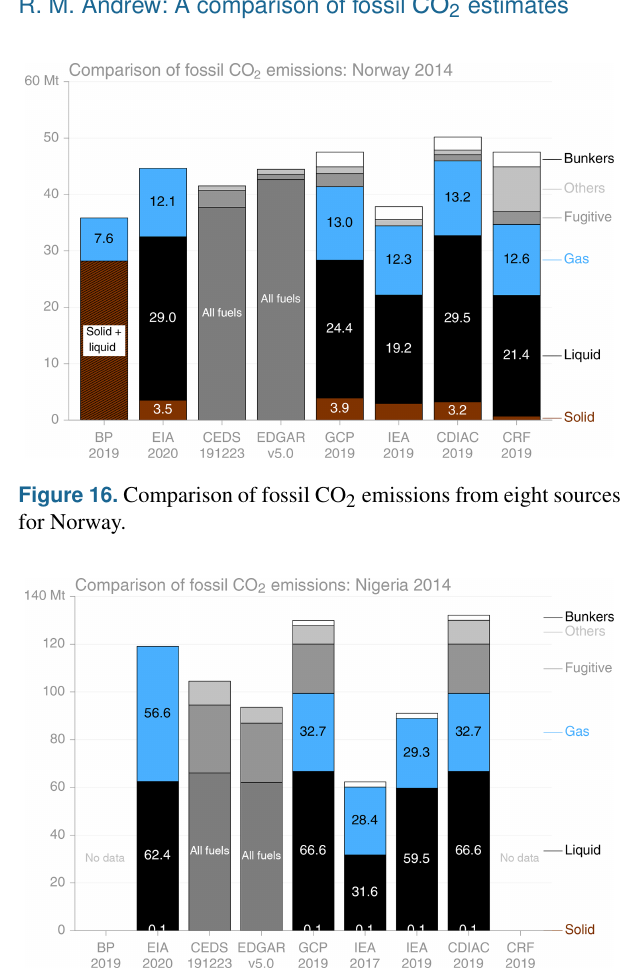
Figure 17. Comparison of fossil CO 2 emissions from seven sources for Nigeria.